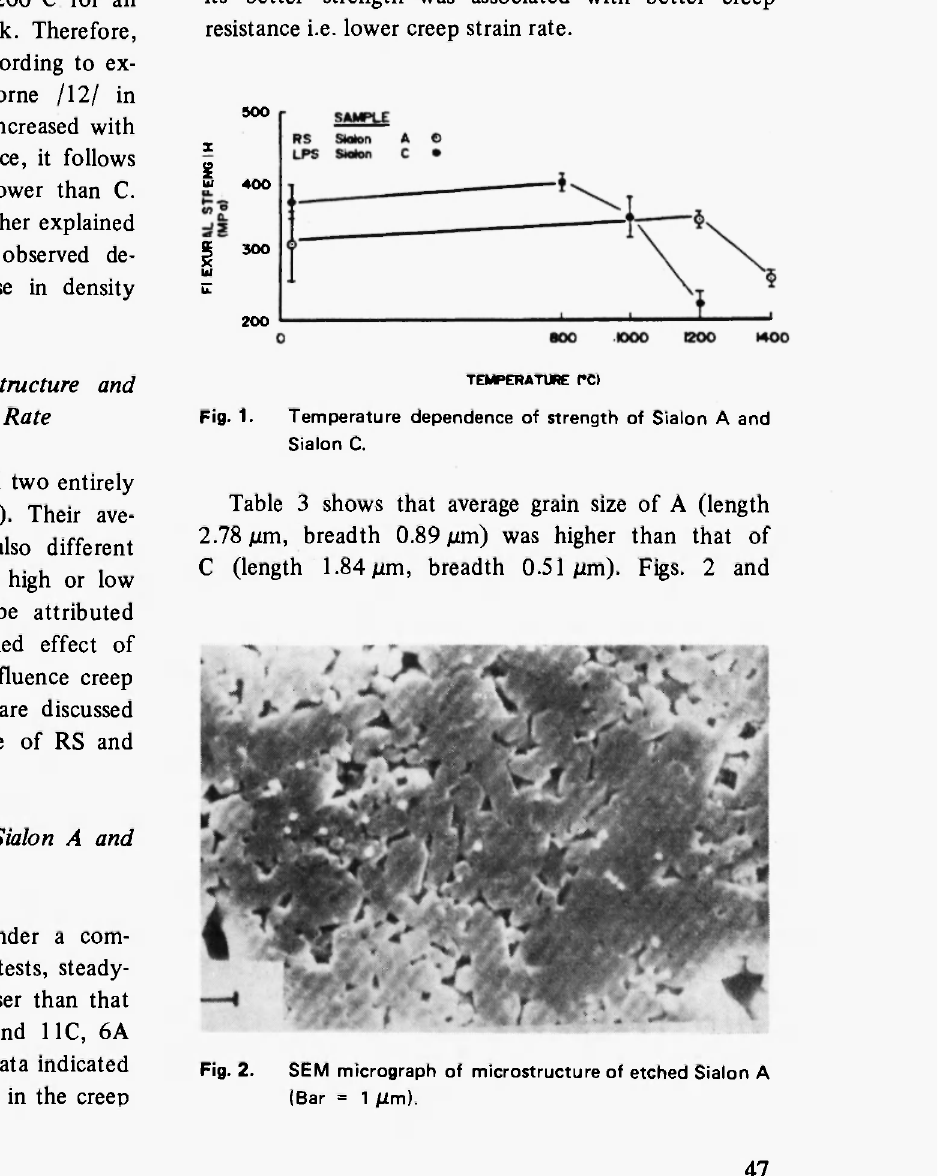
Fig. 1. Temperature dependence of strength of Sialon A and Sialon C.